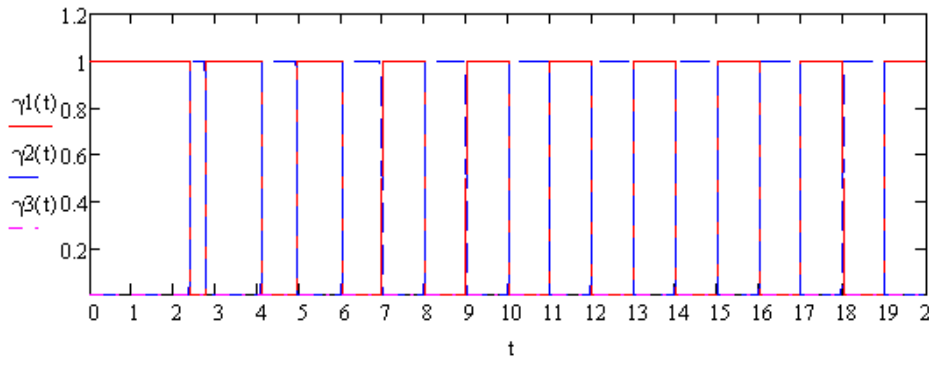
Figure 5. Optimal observation plan.